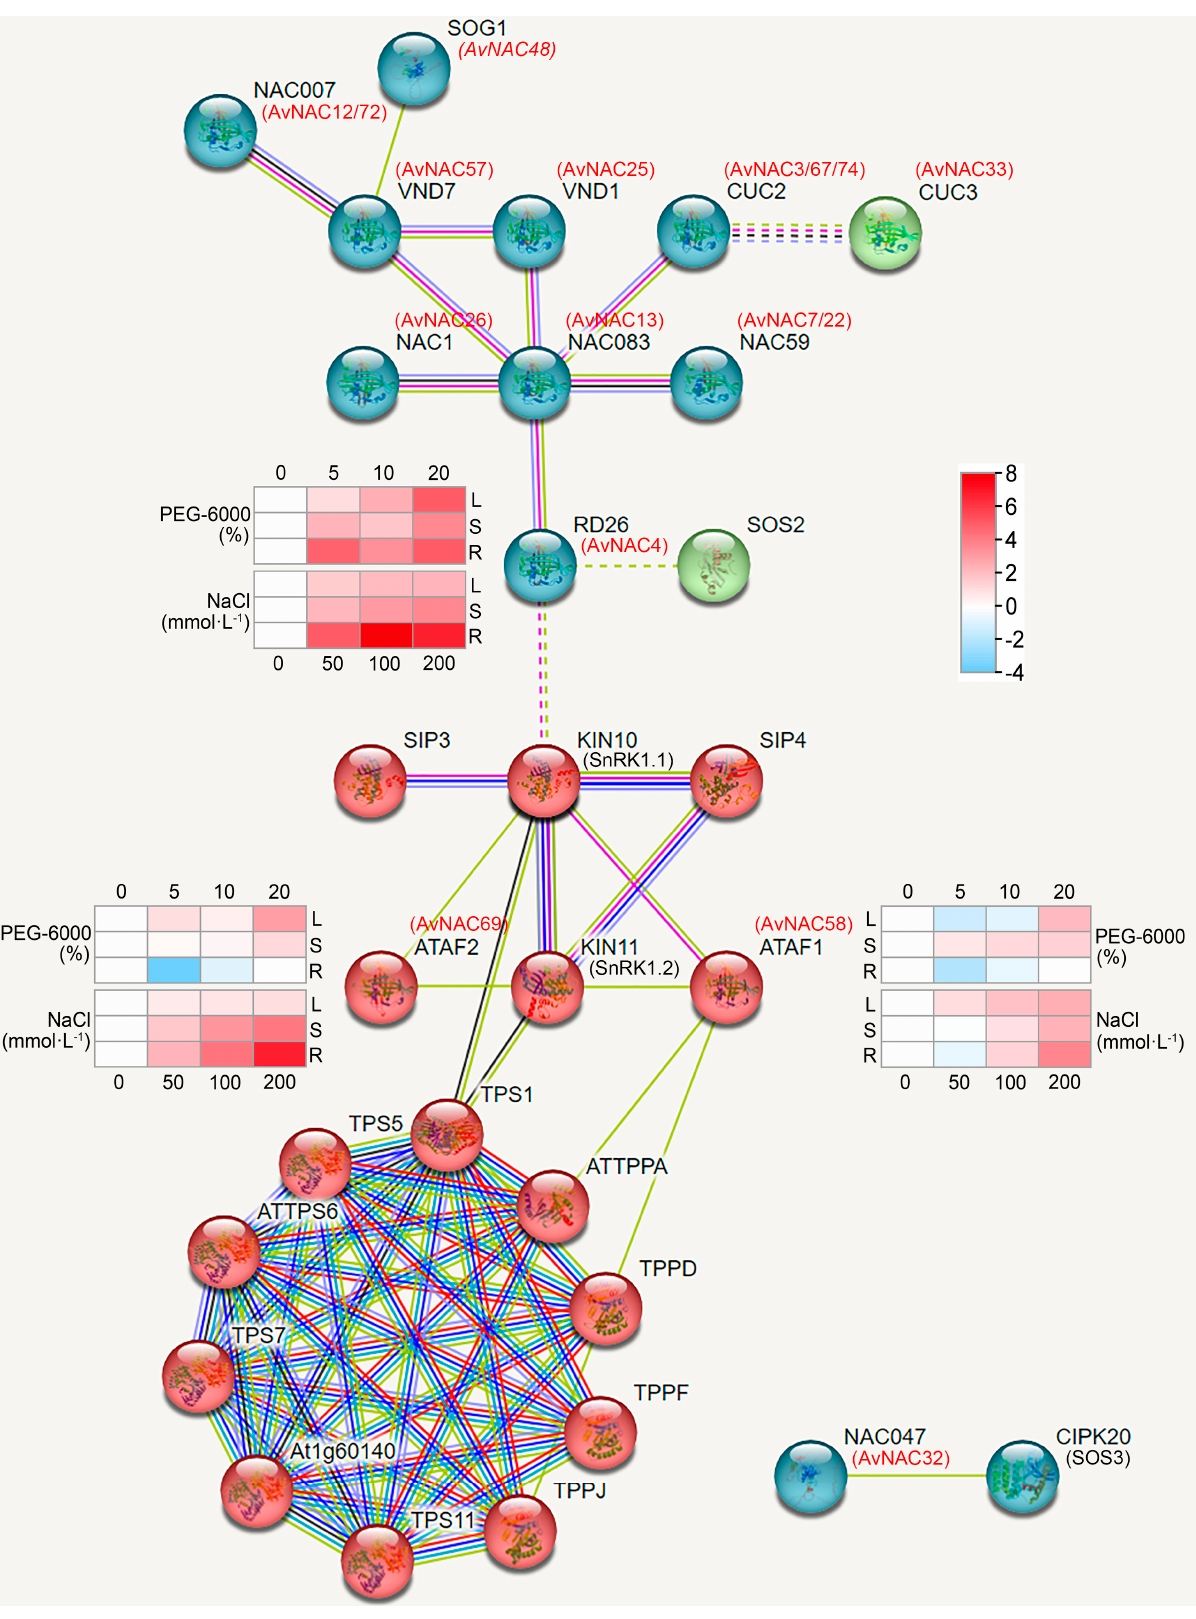
Figure 10. Protein − protein interaction of AvNAC proteins. Figure 10. Protein-protein interaction of AvNAC